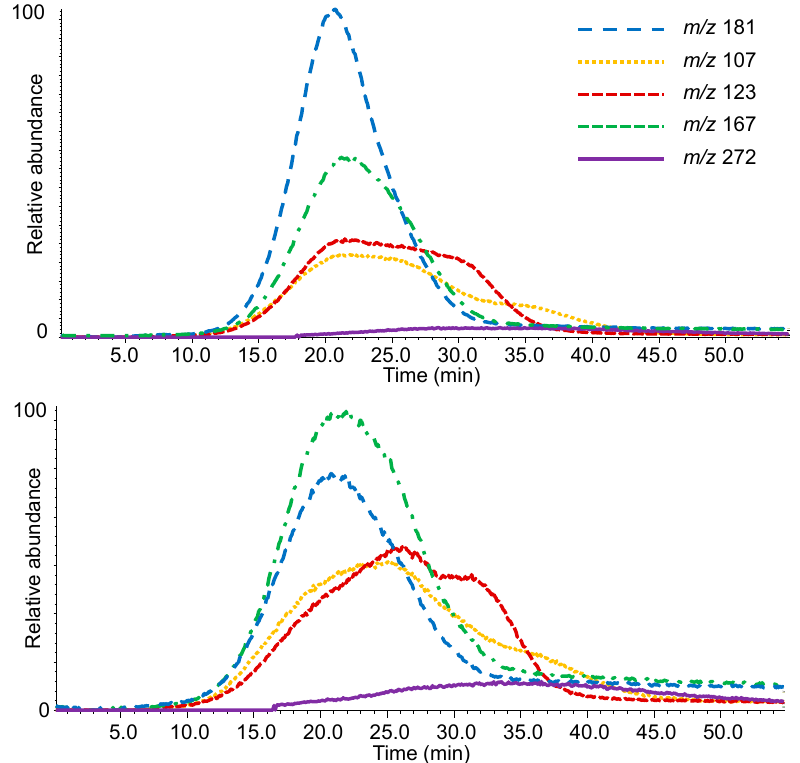
Figure 5. Extracted ion thermograms (EITs) of specific m / z values for sample B (rings 16–20) from the surface ( top ) and sample F (rings 41–45) from the core ( bottom ) of pile 2212 from La Marmotta. The lignin alteration in the archaeological woods was also evaluated considering the peaks at m / z 151 and 181, characteristic of the lignin oxidation, at m / z 272, 302, and 332, related to the level of lignin depolymerisation, and at m / z 137 and 167, indicative of guai- acol and syringol species p- substituted with a free benzylic position (Table 2).